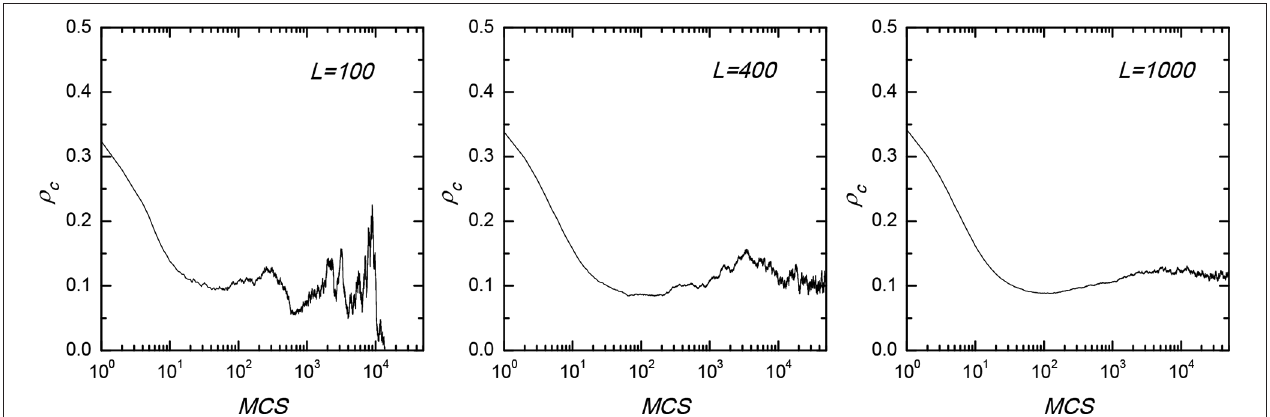
FIGURE 3 | Time courses of the evolution of cooperation for lattice size L equal to 100 (left), 400 (middle), and 1,000 (right). During the simulations, large network size is needed, otherwise cooperation will become extinct due to the fluctuations. With the increase of network size, fluctuations become weaker, making results independent of the network size. The temptation to defect b is set to 1.095, and the exit cost γ is fixed as 3.